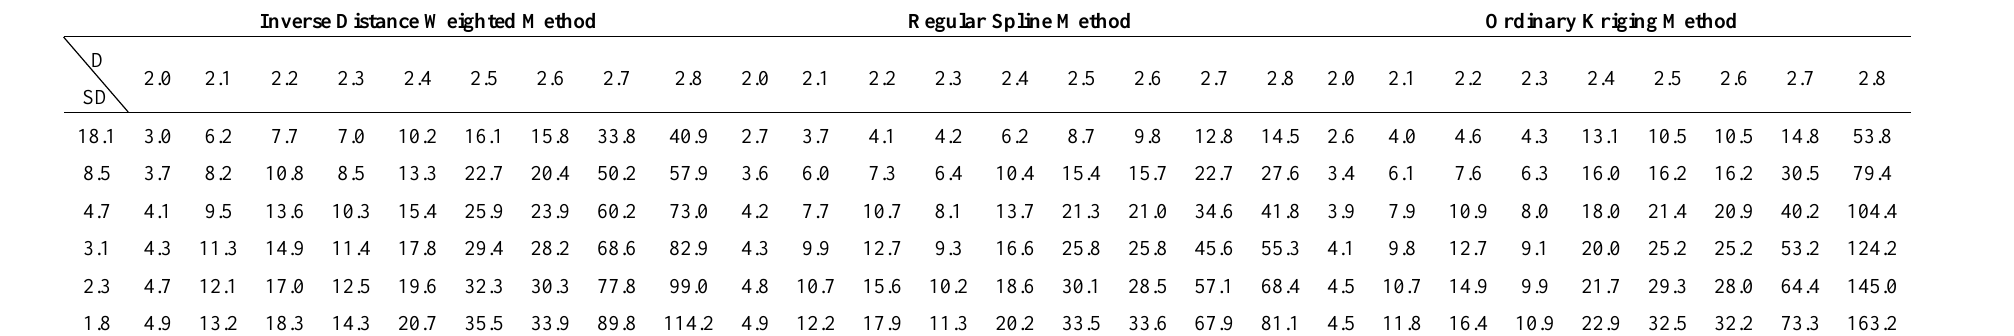
Table 7. The RMSE s under regular-grid sampling mode (Unit: m).